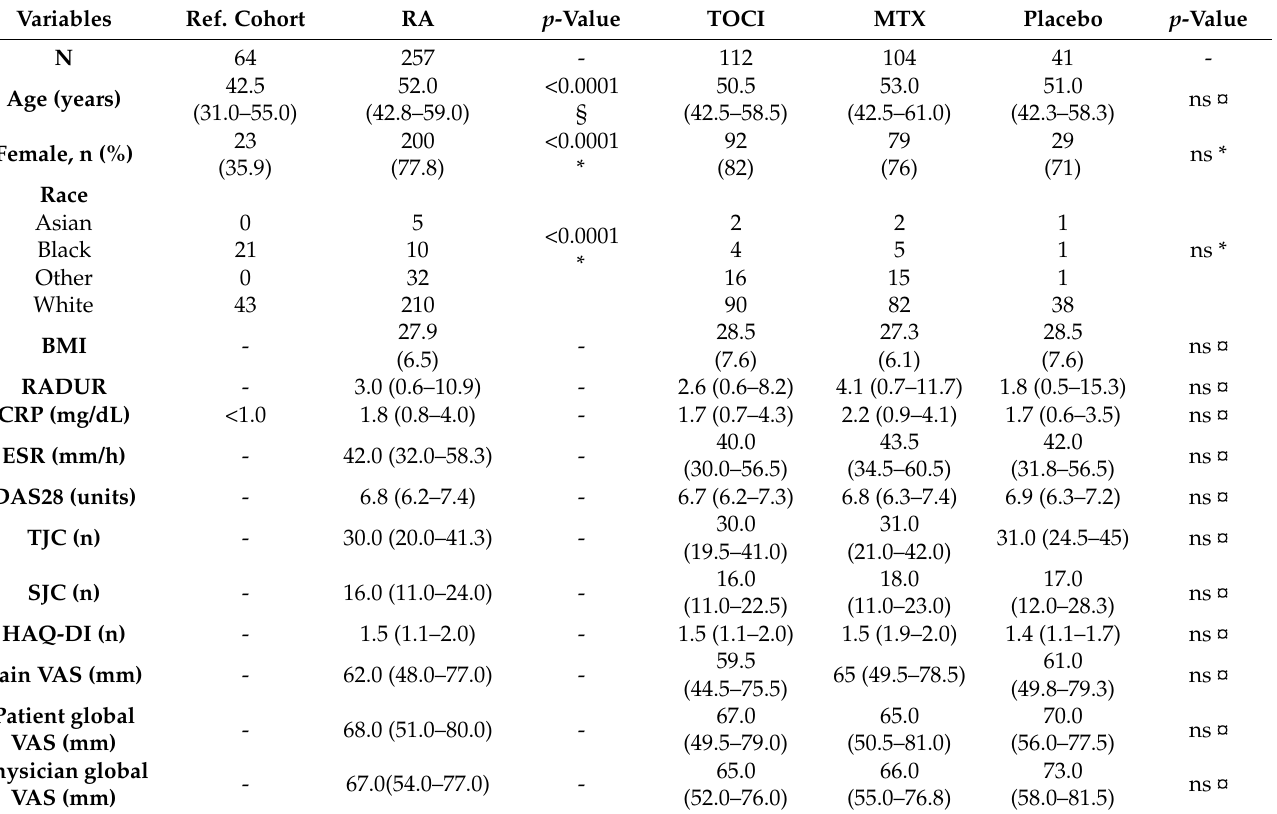
Table 1. Patient demographics overview. Assessment of differences between the normal reference range cohort and the AMBITION study (baseline), and between the treatment arms of the AMBITION study. Data are shown as median (IQR) unless other noted. The differences were tested using non-parametric tests, either by §Mann–Whitney test, * Chi-squared test or ¤ Kruskal–Wallis test. ns, non-significant.